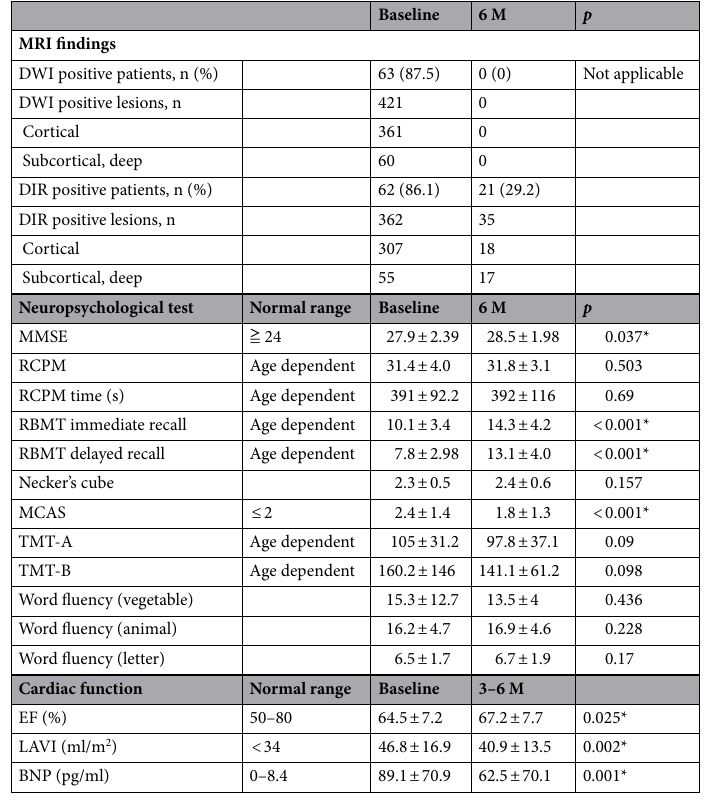
Table 2. Comparison between findings at baseline and 6 months after ablation. DWI Diffusion-weighted imaging, DIR Double inversion recovery, MCAS Mie constructional apraxia scale, EF Ejection fraction, LAVI Left atrial volume index, BNP Brain natriuretic